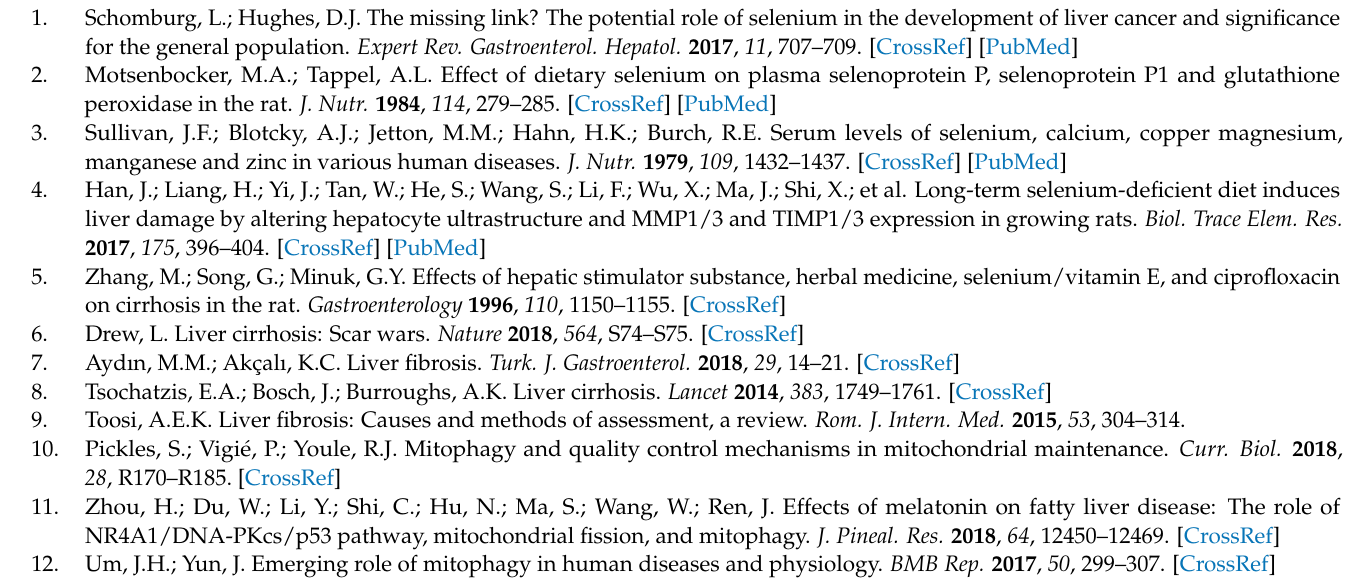
HMDB_taxonomy in liver samples from normal and low-selenium groups. Table S2: Differential metabolites and their HMDB_taxonomy in liver samples from low-selenium and nano-selenium supplement-1 groups. Table S3: Differential metabolites and their HMDB_taxonomy in liver samples from low-selenium and nano-selenium supplement-2